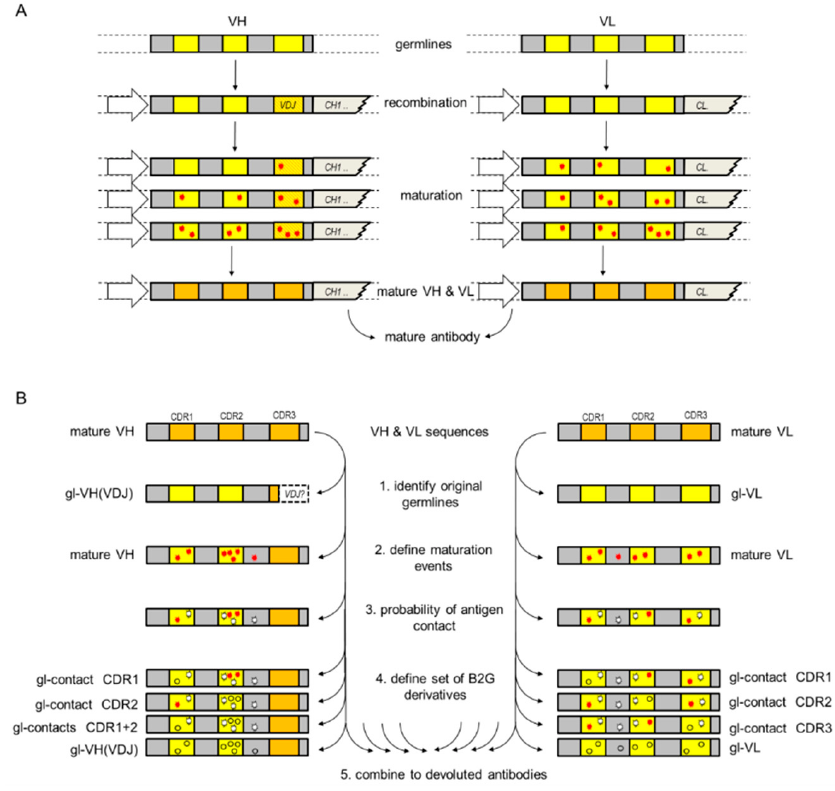
Figure 1. Antibody maturation ( A ) in B cells and ( B ) de-maturation by B2G.